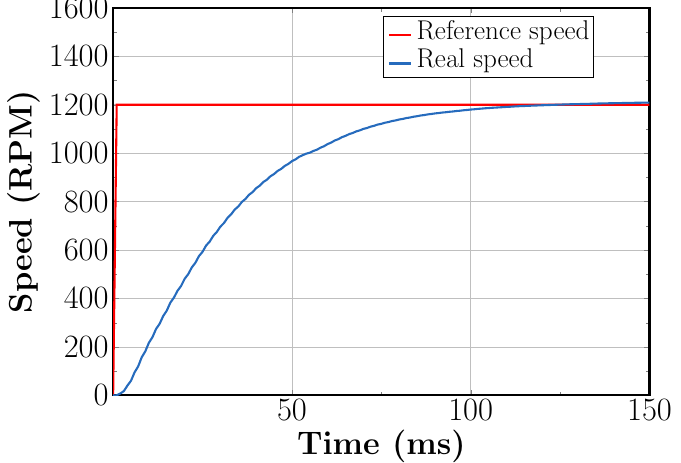
Figure 13. Sensorless speed control for 1200 RPM, speed reference and real speed of the